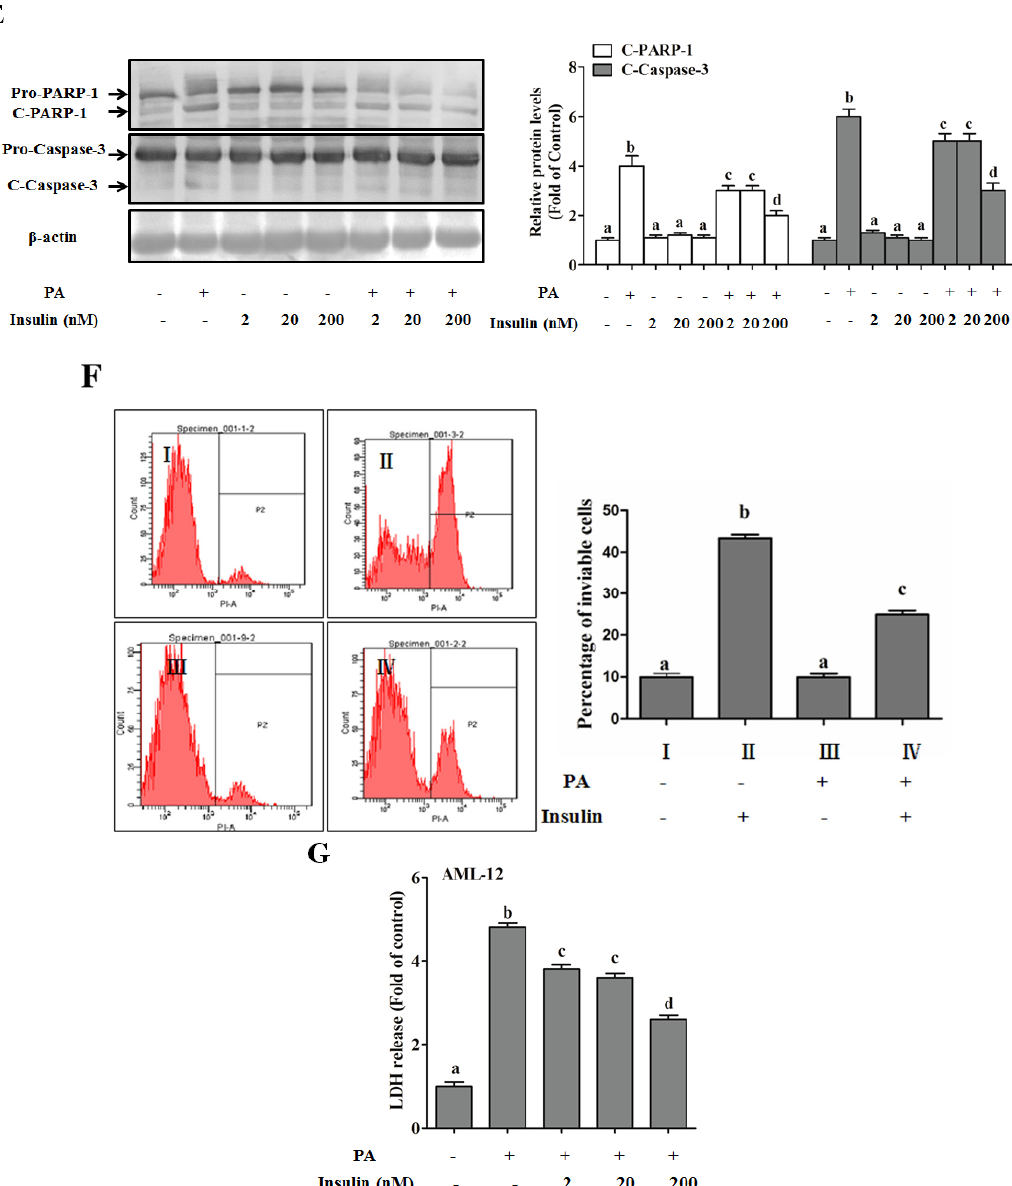
Figure 3. Insulin protects against SFA ‐ induced hepatotoxicity. Mouse plasma insulin level was detected as described in the Materials and methods ( n = 8). HepG2 cells were exposed to palmitic acid (PA, 400 μ M) with or without different dose of insulin pretreatment for 1 h. ( A ) Plasma insulin; ( B ) LDH in the cultured medium was detected as described in the Methods; ( C ) Cell viability was detected by MTT test; ( D ) Nuclear morphology was detected by Hoechst staining using fluorescence microscopy (magnification × 100); ( E ) Total lysates of HepG2 cells were subjected to immunoblotting assay for Caspase ‐ 3 and PARP ‐ 1; ( F ) Cell death was dectected by propidium iodide staining with flow cytometry; ( G ) AML ‐ 12 hepatocytes were used to replace HepG2 cells. LDH in the cultured medium was detected as described in the Methods. Each in vitro test was performed at least 3 times. Bars with different characters differ significantly ( p < 0.05).